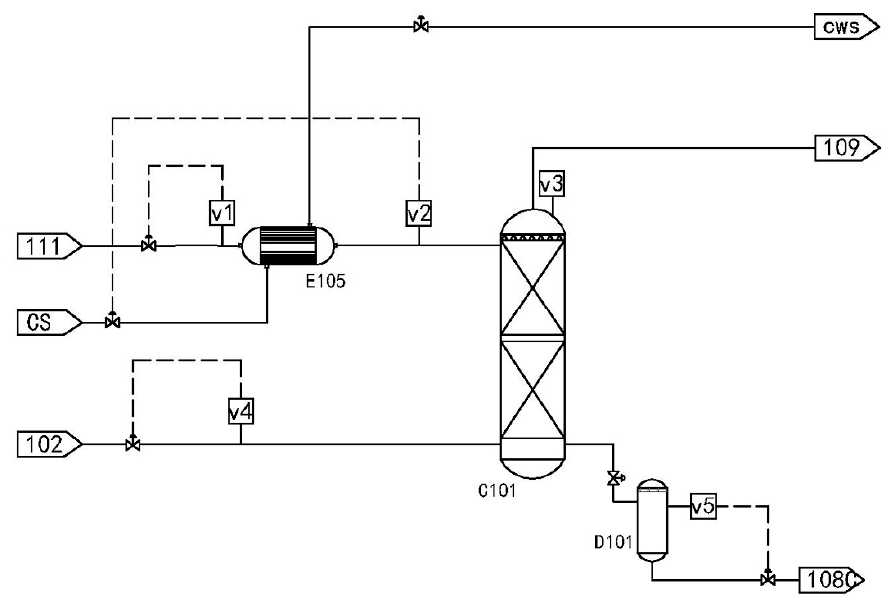
Figure 9. Acid gas adsorption process flow chart. Table 5. Three faults in acid gas adsorption process.